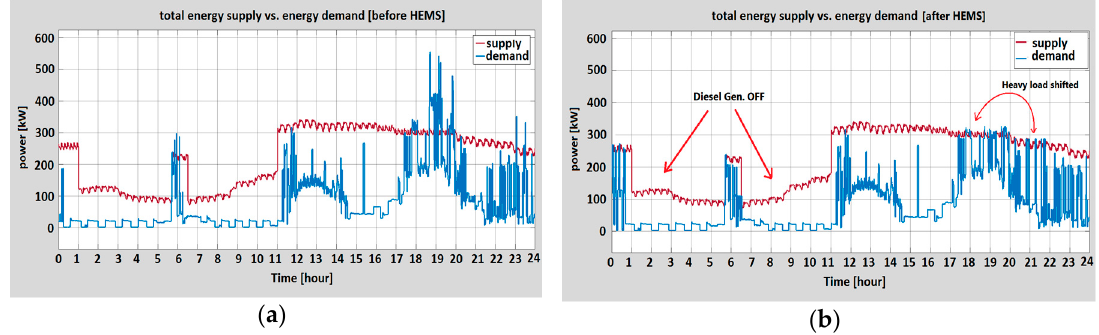
Figure 22. ( a ) Total energy supply and energy demand in Scenario C (Wind and Diesel gen.) before HEMS, and ( b ) after HEMS.